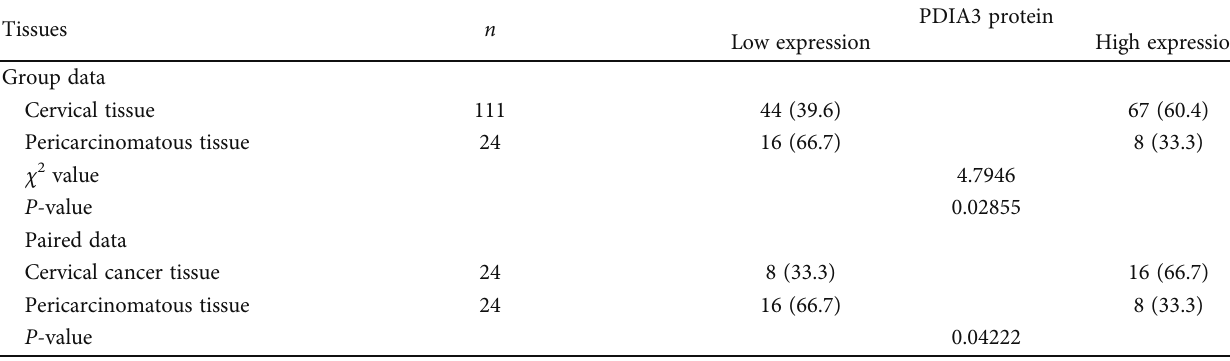
Table 1: Expression of PDIA3 protein in cervical cancer tissues and adjacent cancer tissues [ n (%)].